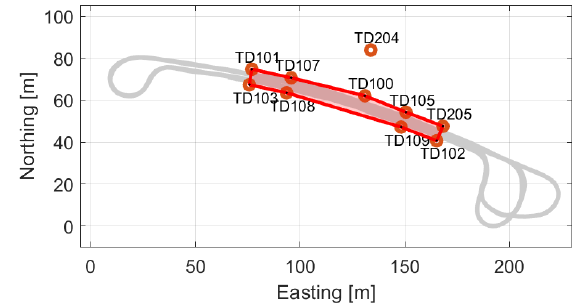
Figure 1. Three vehicles during the test.